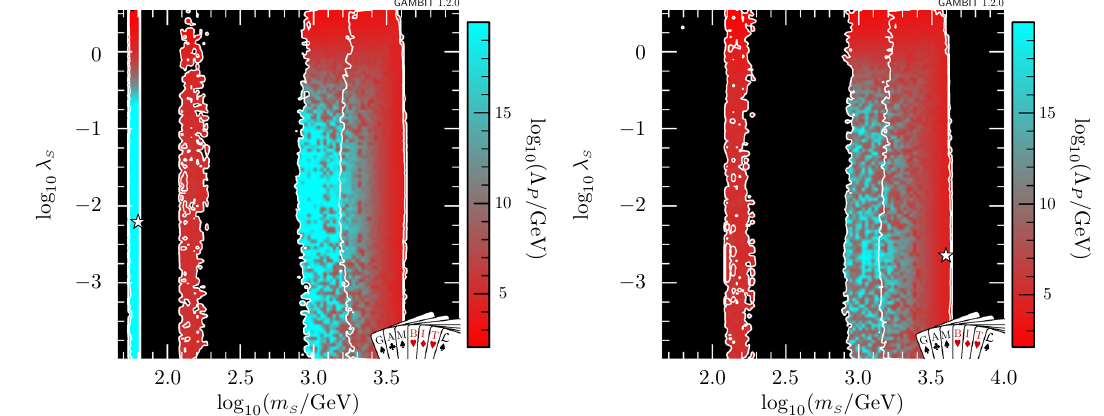
Fig. 5 Scaleofperturbativityviolationwithrespectto m S and λ S forthe Z 2 scalar singlet model with the requirement that only (left) and with the additional requirement of absolute vacuum sta-